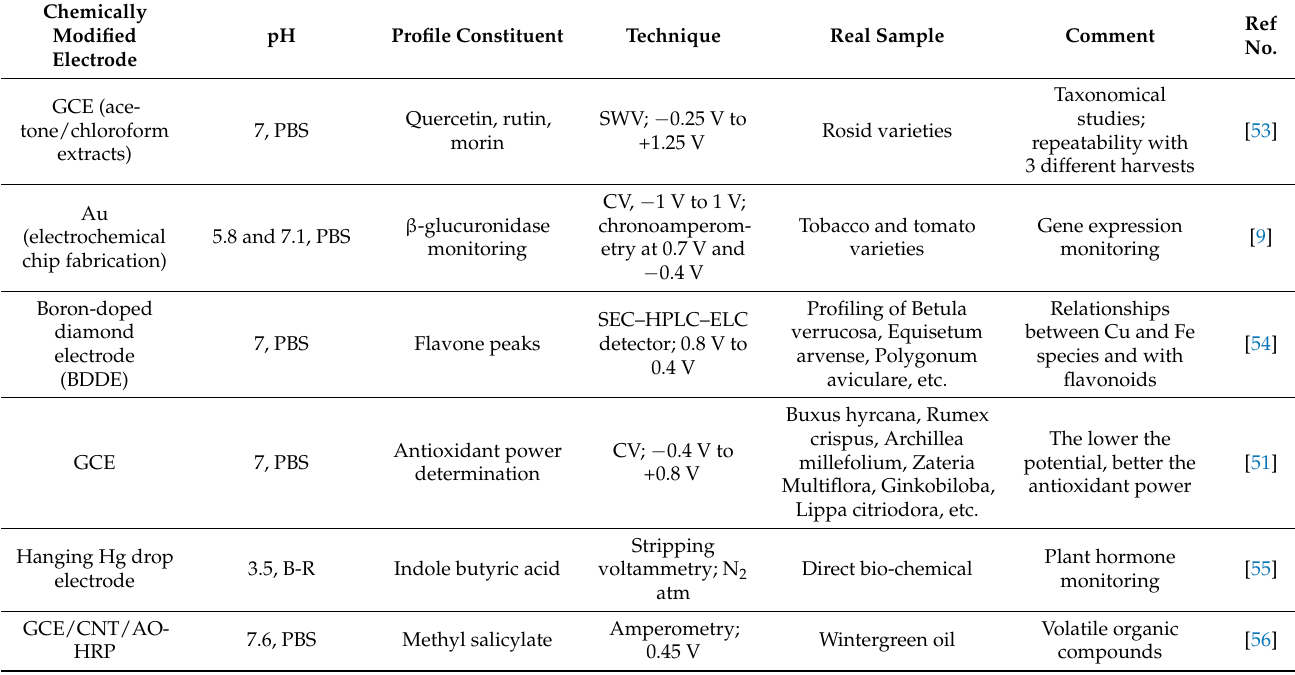
Table 1. Tabulation of distinct types of electrochemical sensors and the scope of their applications reported by researchers in since